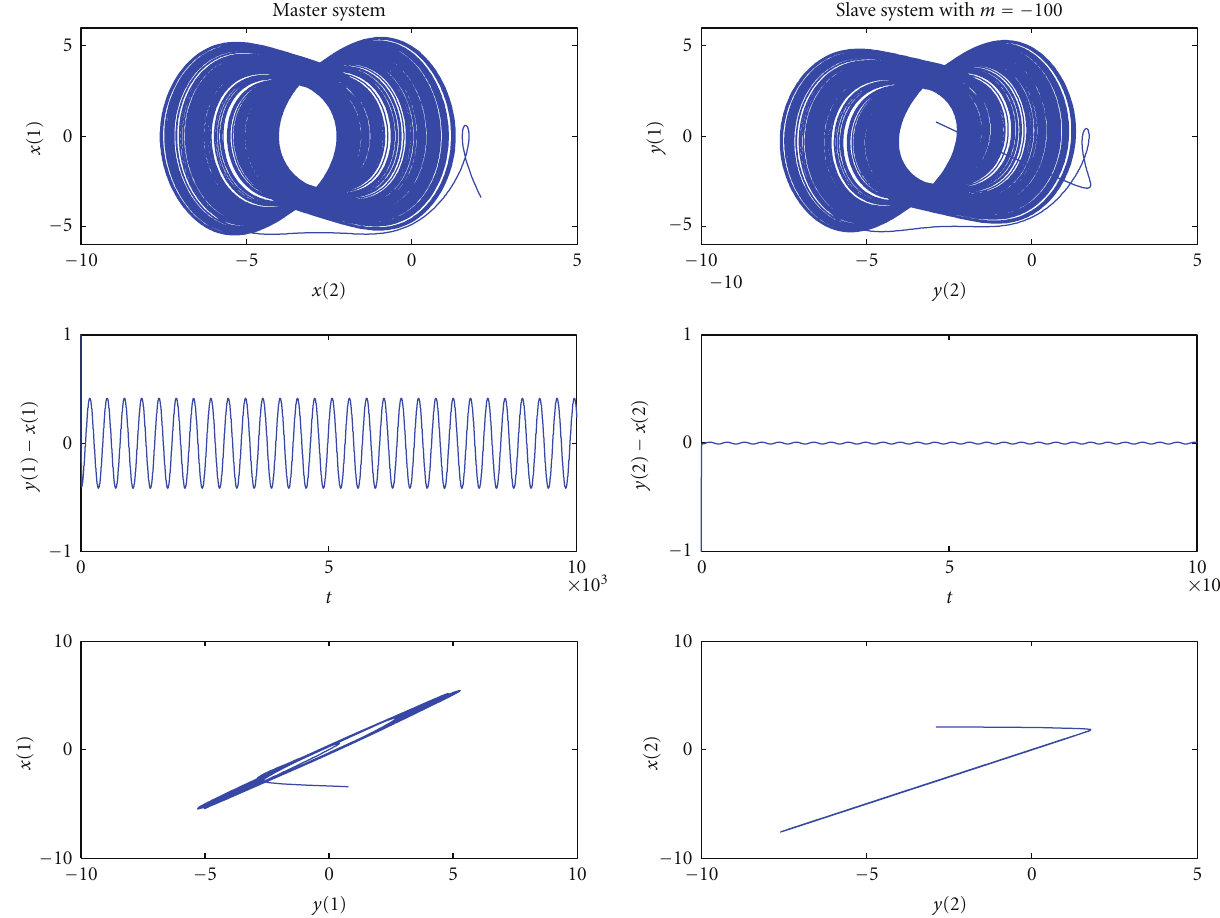
Figure 4: Phase portrait, errors, and similarity of unidirectional coupled systems with k = − 50 and m = − 100 .